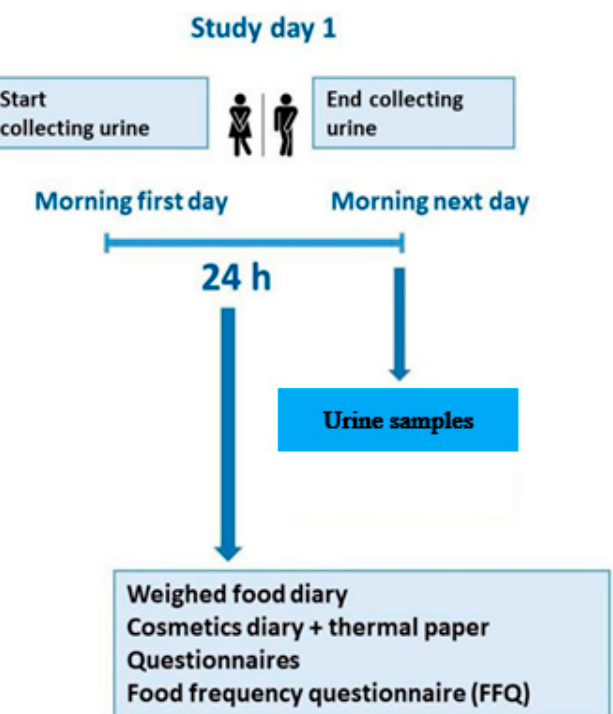
Figure 1. Graphical presentation of the human biomonitoring study design.